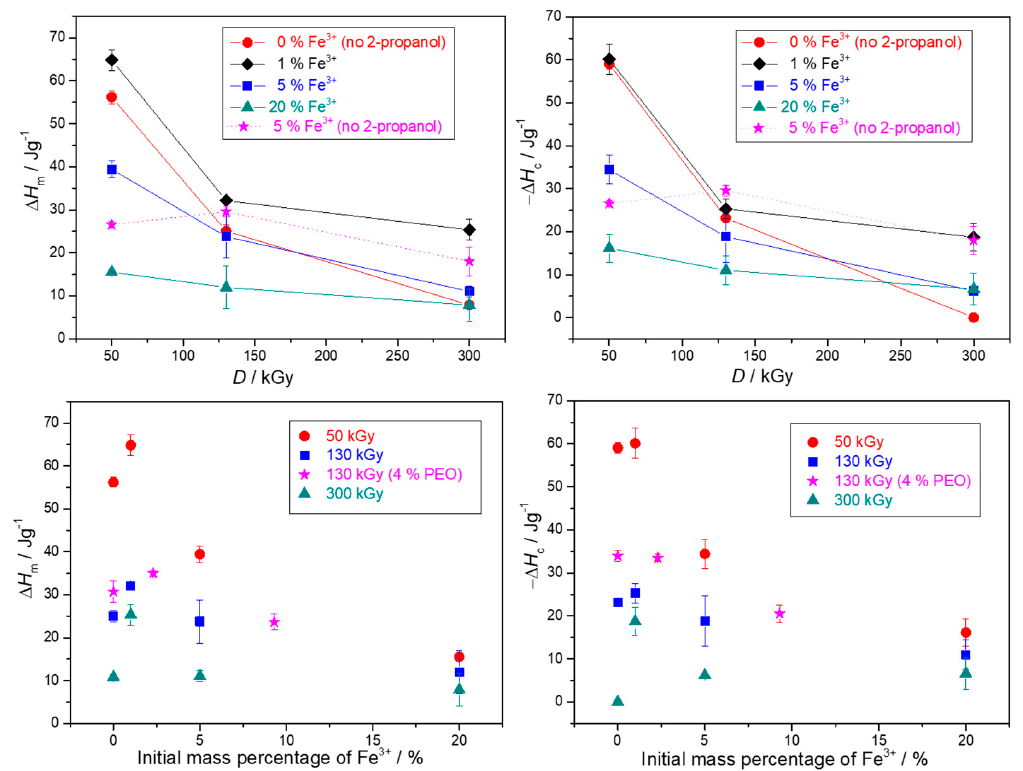
Figure 10. Melting ( ∆ H m ) and crystallization ( ∆ H c ) enthalpies of the 2nd heating cycles and 1st cooling cycles, respectively, of the obtained gels in dependence on the irradiation dose and the mass percentage of Fe 3 + in precursor suspensions. Unless otherwise indicated, the precursor suspensions were prepared from 1.85 wt% PEO solutions and with 0.2 M 2-propanol. Mass percentage of Fe 3 + of 1, 5, 20 wt% (relative to total PEO and Fe 3 + mass) in the precursor suspensions correspond to concentrations of Fe 3 + ions of 0.35 × 10 − 2 M, 1.75 × 10 − 2 M, and 7 × 10 − 2 M in the case of 1.85 wt% PEO suspensions. In the case of 4 wt% PEO suspensions, Fe 3 + concentrations of 1.75 × 10 − 2 M and 7 × 10 − 2 M correspond to 2.3 and 9.3 wt% Fe 3 + .